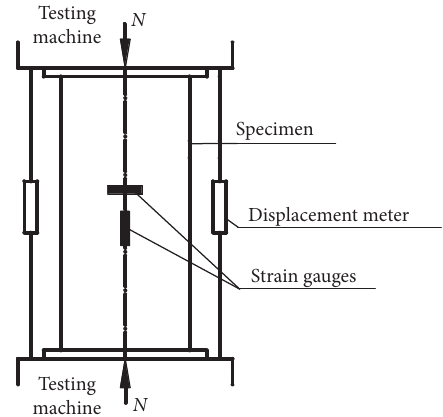
Figure 3: Sketch map of loading device and locations.